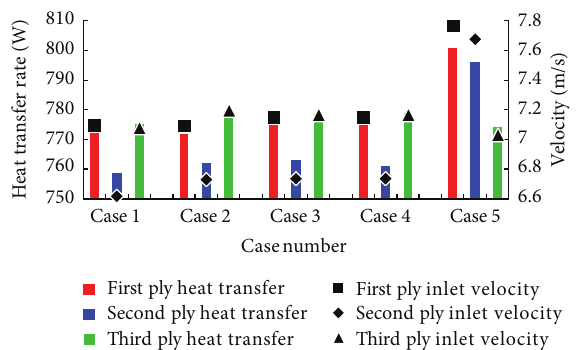
Figure 7: Variation of heat transfer rate with respect to inlet velocity at 20 L/min in various cases.